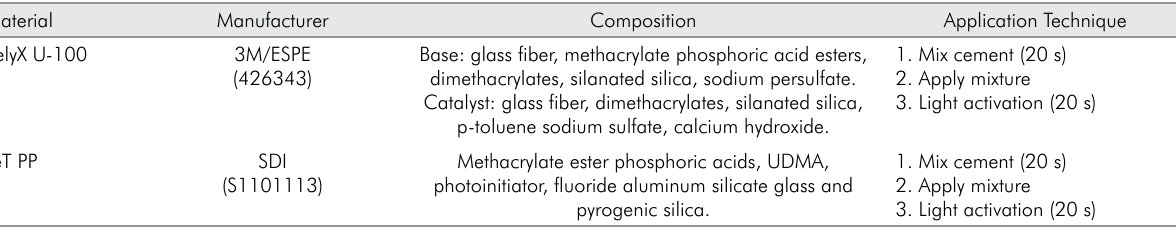
Table 1. Manufacturer, composition, and application mode of the self-adhesive resin luting cements used in this study. Material Composition Application